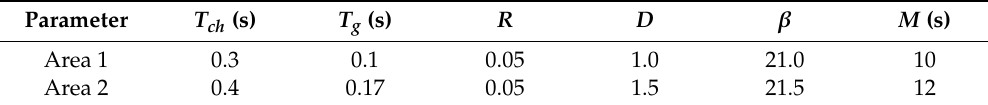
Table A1. Parameters of two control areas.